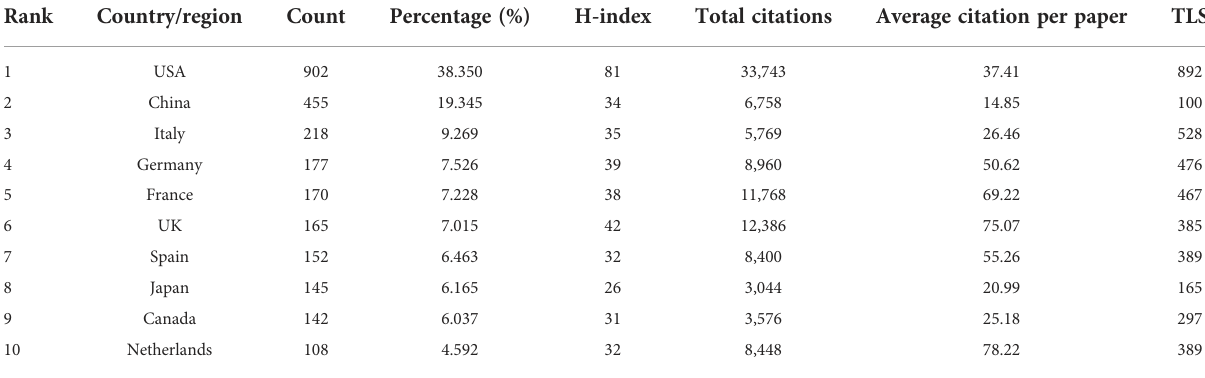
TABLE 1 The Top 10 countries/regions that contributed to the publications on BC immunotherapy